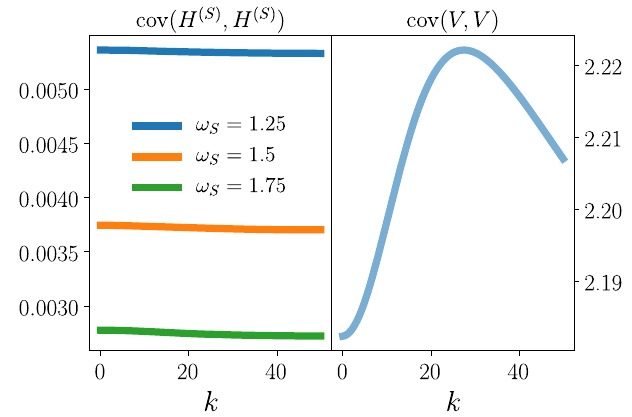
k Þ ; i.e., the thermal- max ð FIG. 7. Bounds on the dissipated work: Covariance matrices. In g Þ(cid:2) ¼ log ½ τ V g 0 Þ(cid:2) − ν log ð k Þ . V Eqs. (9) and (7) we bounded the dissipated work by employing eq ð eq ð 1 . 97 and g 2 τ V ˜ H; ˜ H g 0 Þ ¼ 1 . 1 . the covariance cov ω ð Þ . Note that the covariance of H s and V 0 V ¼ eq ð t 0 . 01 . stays bounded for very large values of k S ¼